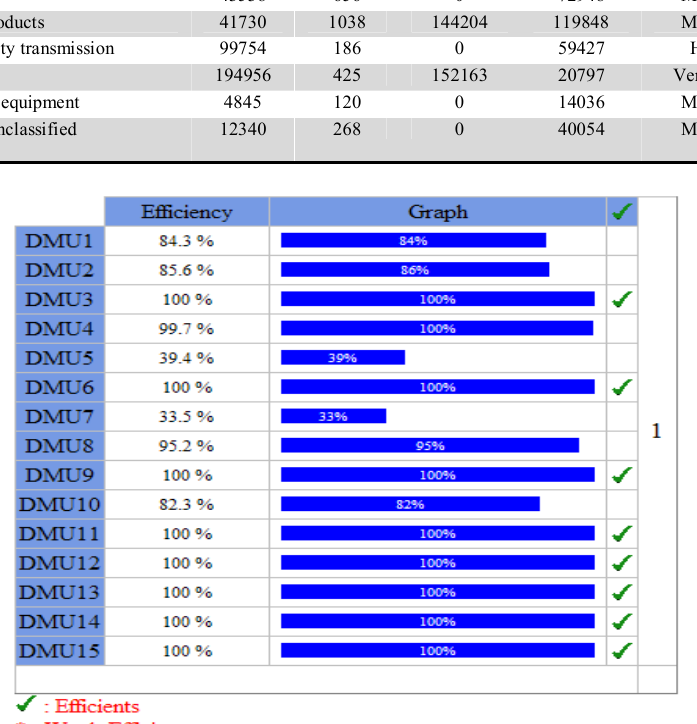
Fig. 1. The results of the implementation of DEA method